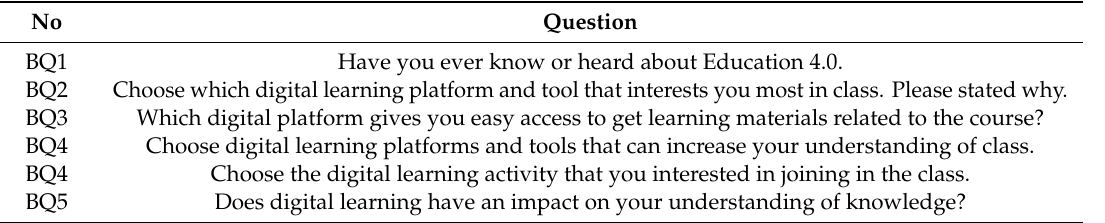
Table 4. Survey items for Section